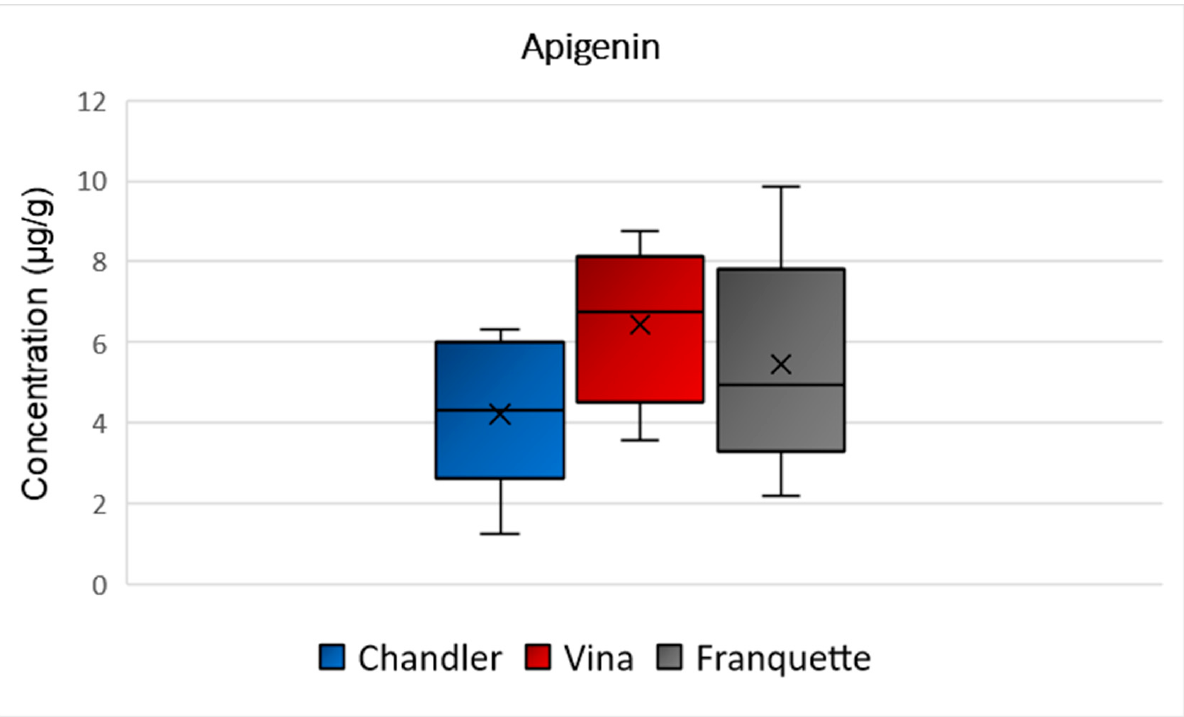
Figure 7. Box and Whisker plot for the concentration of apigenin among walnut septa belonging to the Chandler, Vina, and Franquette varieties.